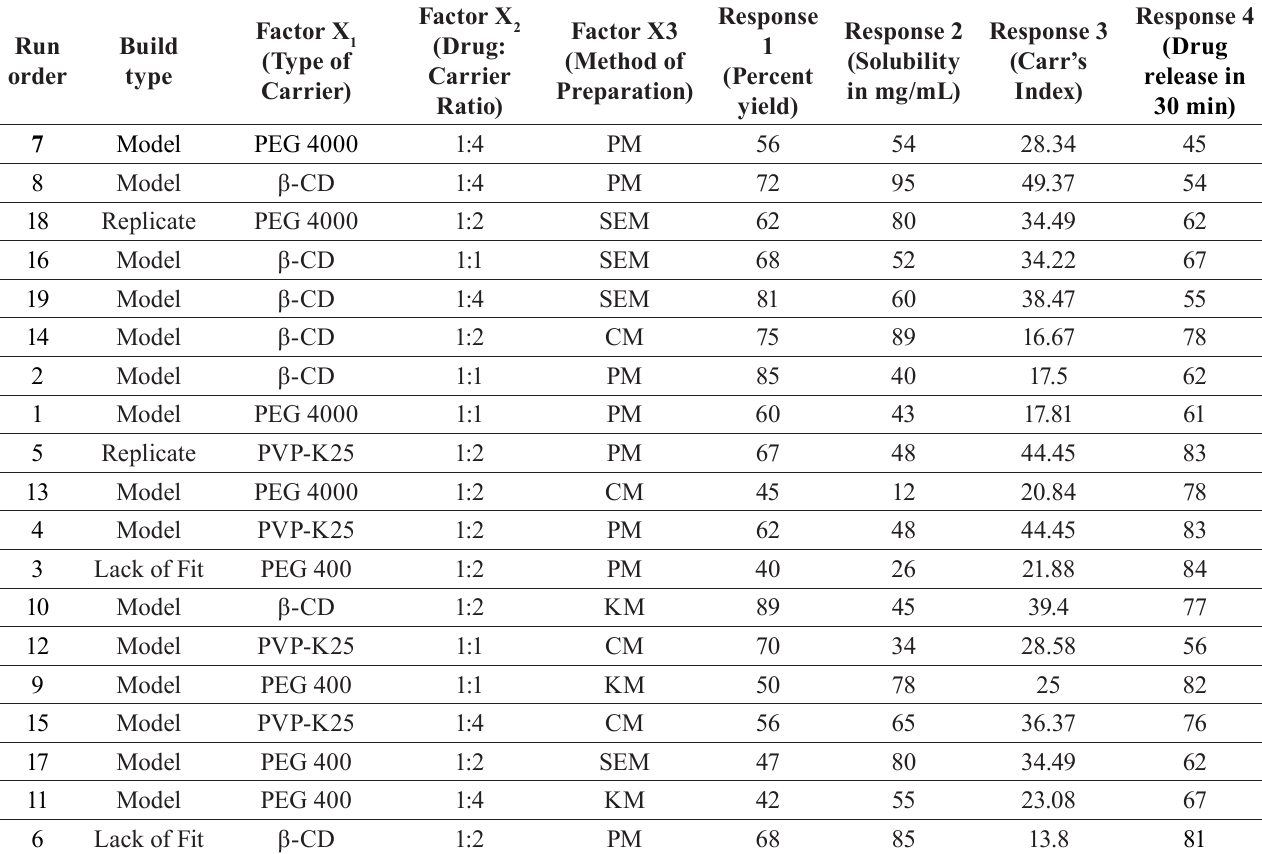
TABLE III - Design matrix enlisting the experimental trial formulations as per the I-optimal design